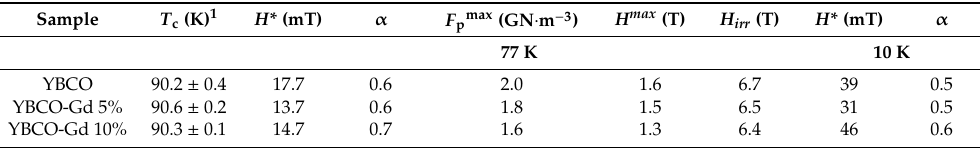
Table 4. Critical temperature ( T c ), cross over fields ( H *), α parameter of the J c power-law dependence ( J c ( H ) = J c (0) × H − α ), maximum of the pinning force densities ( F pmax ), and irreversibility field ( H irr ) for YBCO and YBCO-Gd films deposited with the standard process.